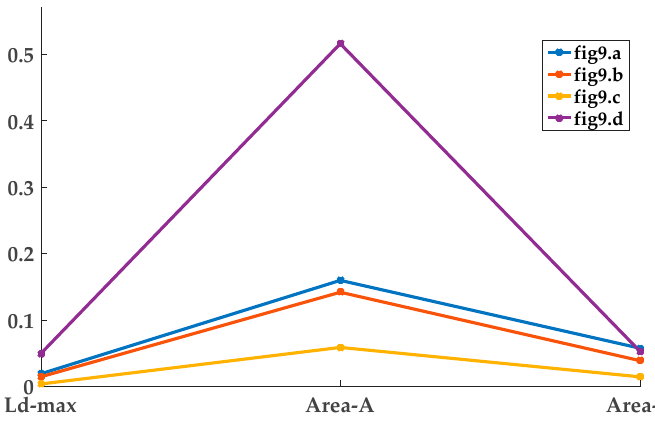
Figure 10. Evaluation chart.